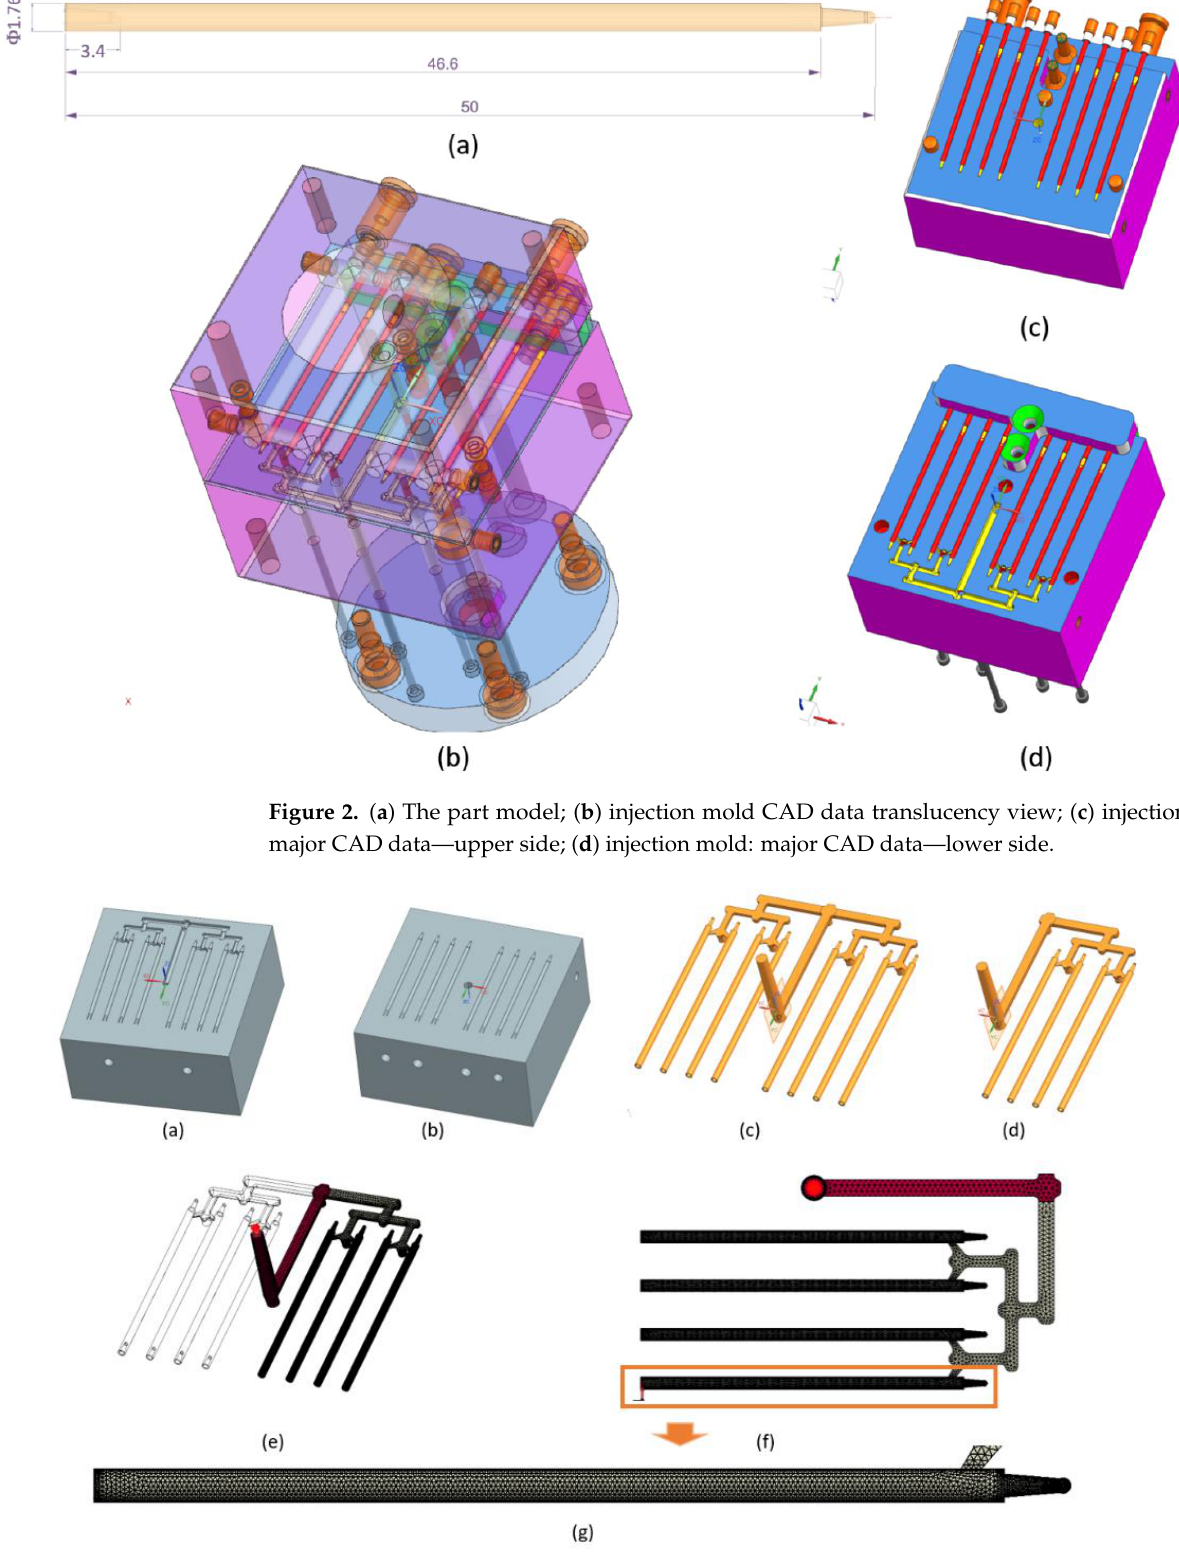
Figure 3. Injection mold, simplified CAD data: ( a ) lower side and ( b ) upper side. Injection part: ( c ) fully CAD data and ( d ) simplified CAD data—one side. 3D mesh simulation model: ( e ) ready to analyze (injection location is visible); ( f ) view from above; and ( g ) stick region.